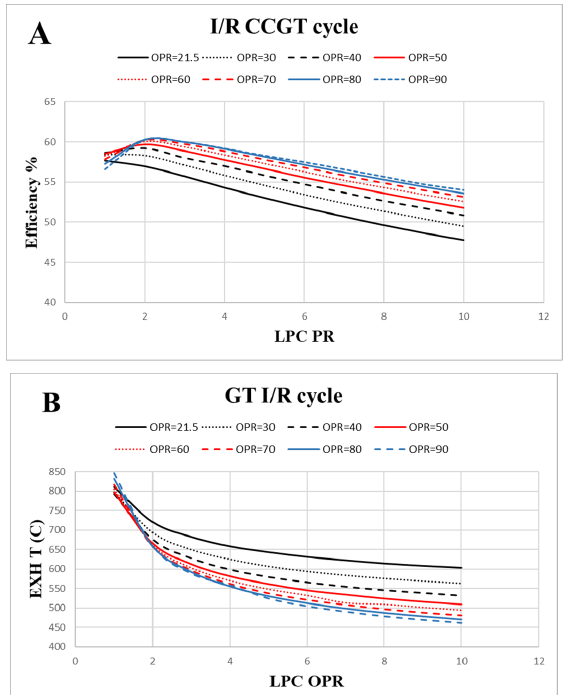
Figure 9. ( A ) Effects of the compression ratio with changing LPC in the I/R CCGT cycle. ( B ) Effects of the compression ratio with changing LPC in the I/R GT cycle. For the D.P. of simple, reheat, and I/R systems, the reheat and I/R cycles compete for efficiency. Thus, we selected those two cycles and examined them at the